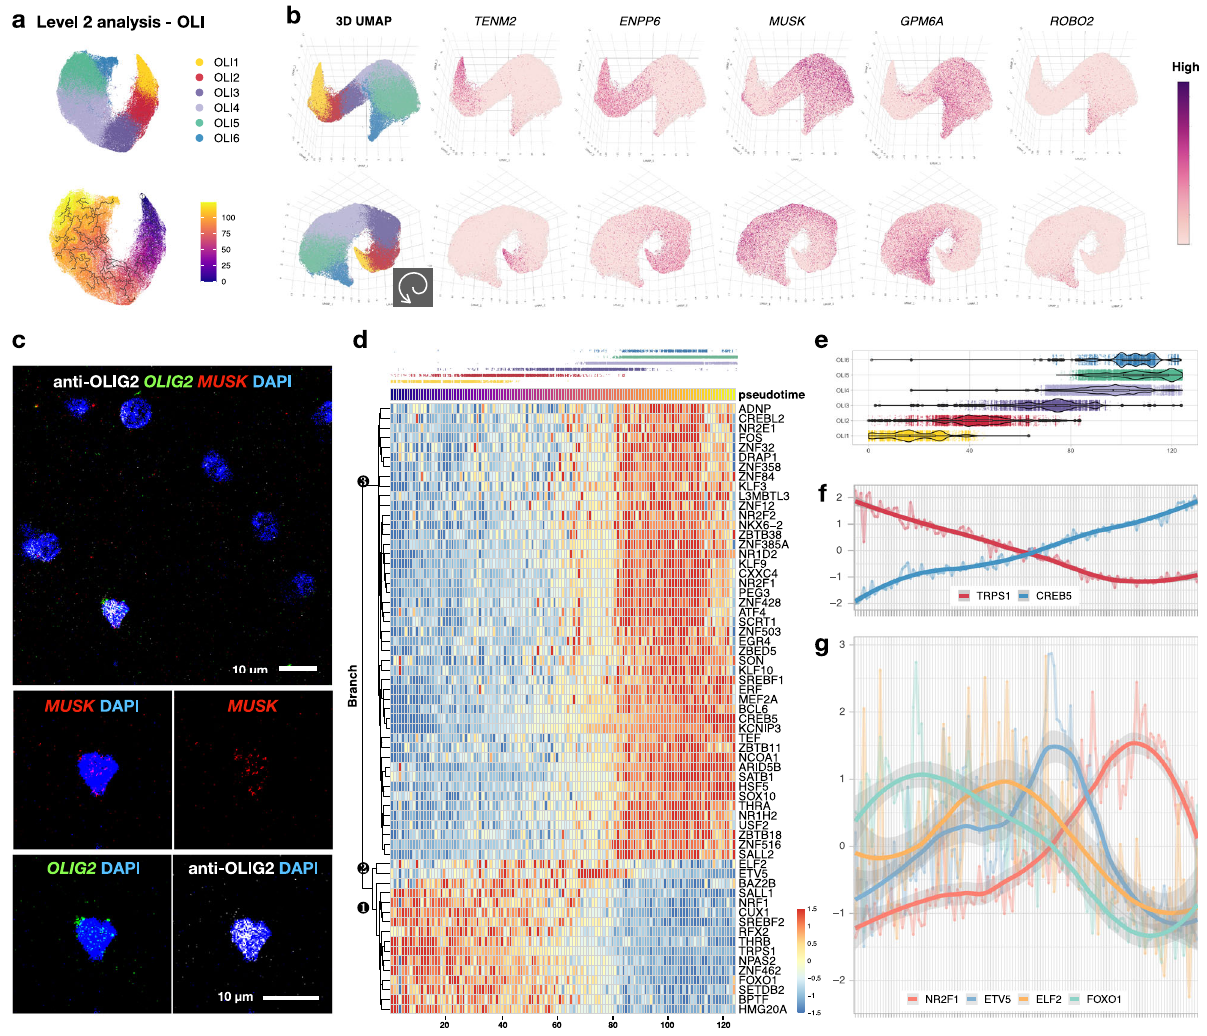
Fig. 5 | The transcriptome of oligodendrocytes lies on a spiral trajectory fl anked by ENPP6 / MUSK gradient and marked by the succession of transcrip- tion factors. a 2D UMAP plot of oligodendrocytes (OLI) colored by Level 2 sub- clustering (top) and transcriptomic distance in pseudotime (bottom, starting at OLI1,denotedby ① ). b Twoviewinganglesofa3DUMAPplotofOLIsubclustersand correspondingexpressionofselectedgenes. c Theexpressionof MUSK isdetected inOLIG2 + cellsinadultmarmosetbrainbycombinedimmuno fl uorescencestaining and fl uorescent in situ hybridization (Hybridization chain reaction